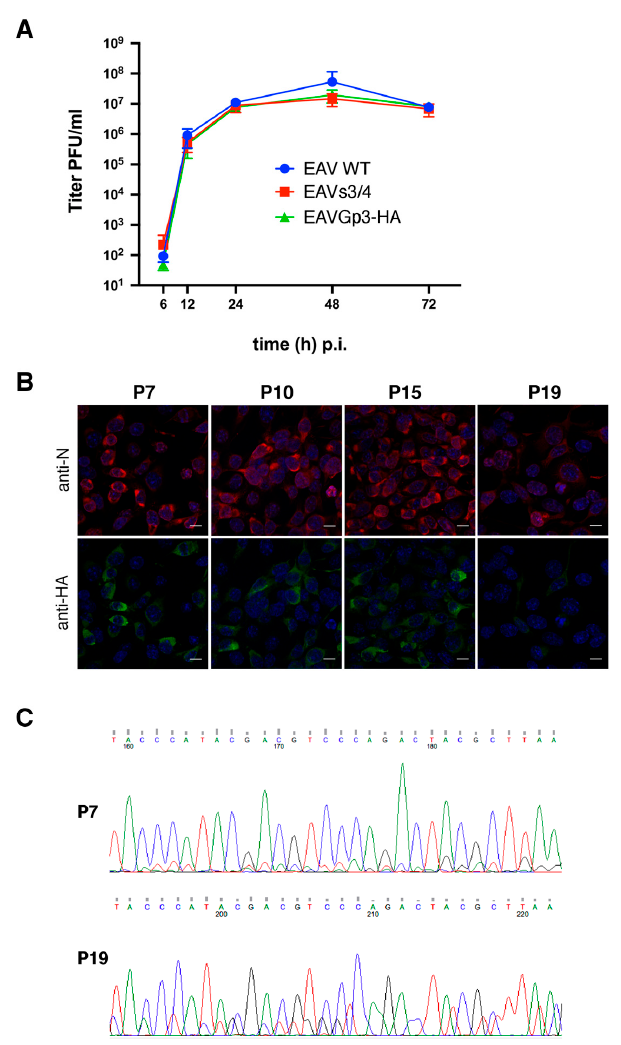
Figure 2. Growth kinetics of the EAV recombinant viruses ( A ). BHK-21 cells were infected with an MOI of 0.1 of P1 stocks of EAV (wt) and recombinant EAVs3 / 4 and EAVGp3-HA viruses. Supernatants were collected at 6, 12, 24, 48 and 72 h post-infection and subjected to plaque assay. PFU / mL—plaque forming unit per mL. Expression of Gp3-HA is stable upon infection ( B ). EAVGp3-HA virus was passaged 19 times on fresh BHK-21 cells. Cells were infected with culture supernatants containing recombinant viruses from passages P7, P10, P15, and P19, and subjected to immunofluorescence assay with anti-HA-tag and anti-N antibodies after 18 h p.i. N is shown in red and Gp3-HA is shown in green. Cell nuclei were stained with DAPI. Chromatograms of viral DNA sequences obtained from EAVGp3-HA infected cells ( C ). Cells infected with P7 and P19 were subjected to RT-PCR. The fragment of the HA-tag nt sequence is shown. The consensus sequence was maintained, but the presence of additional nt peaks in P19 suggested the increase of quasispecies of the